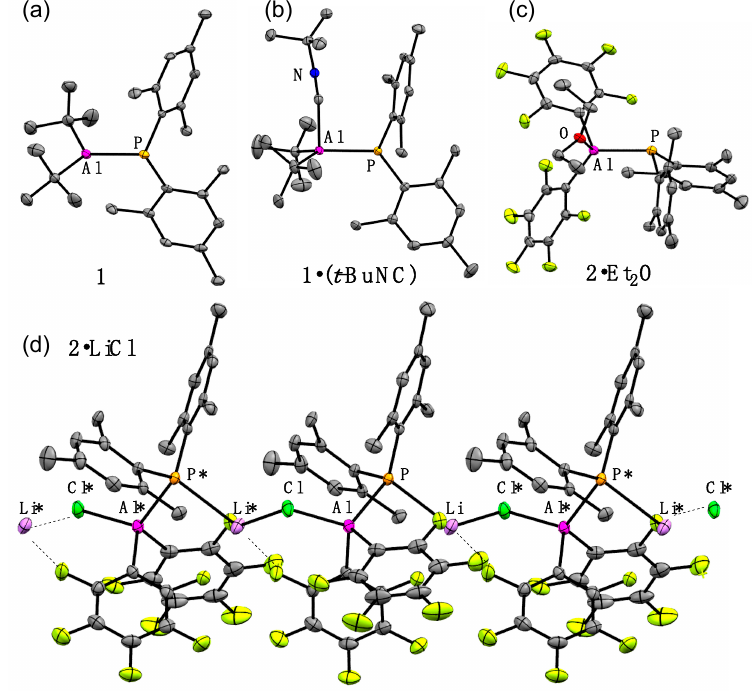
Figure 2. Structures of ( a ) 1 , ( b ) 1 · ( t -BuNC) , ( c ) 2 · Et 2 O , and ( d ) 2 · LiCl (thermal ellipsoids at the 50% probability level). One of the two crystallographically independent molecules of 1 is shown here. Hydrogen atoms and solvent molecules are omitted for clarity. Color code: Al, magenta; C, gray; Cl, green; F, yellow; Li, purple; N, blue; O, red; P, orange. Table 1. Structural parameters of 1 , 1 · ( t -BuNC) , 2 , 2 · LiCl , 2Cl − , and 2 · Et 2 O .